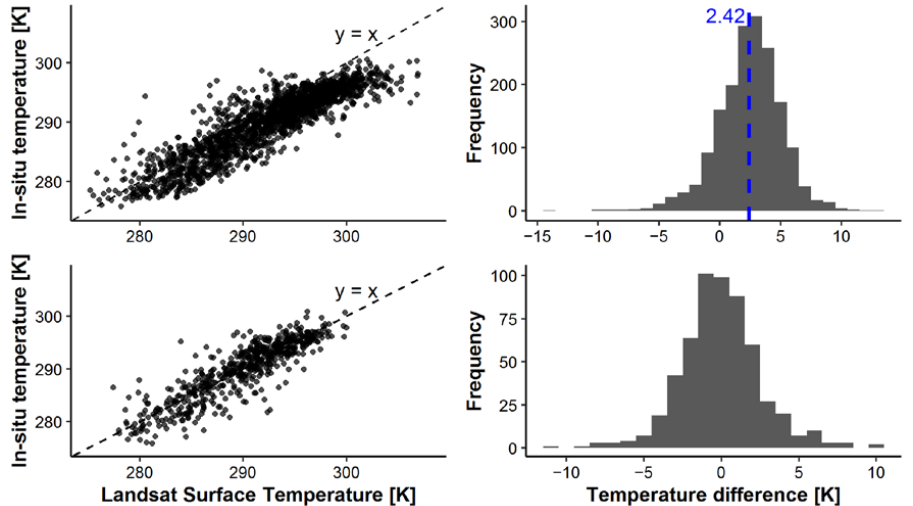
Figure 9. The difference between in situ temperature and LST-L2 in the scatter plot (first column) and histogram (second column). The first row represents uncalibrated training data, while the second row represents calibrated testing data. The blue dashed line indicates the mean systematic error of approximately 2.42 K. After the calibration, the systematic error was corrected.